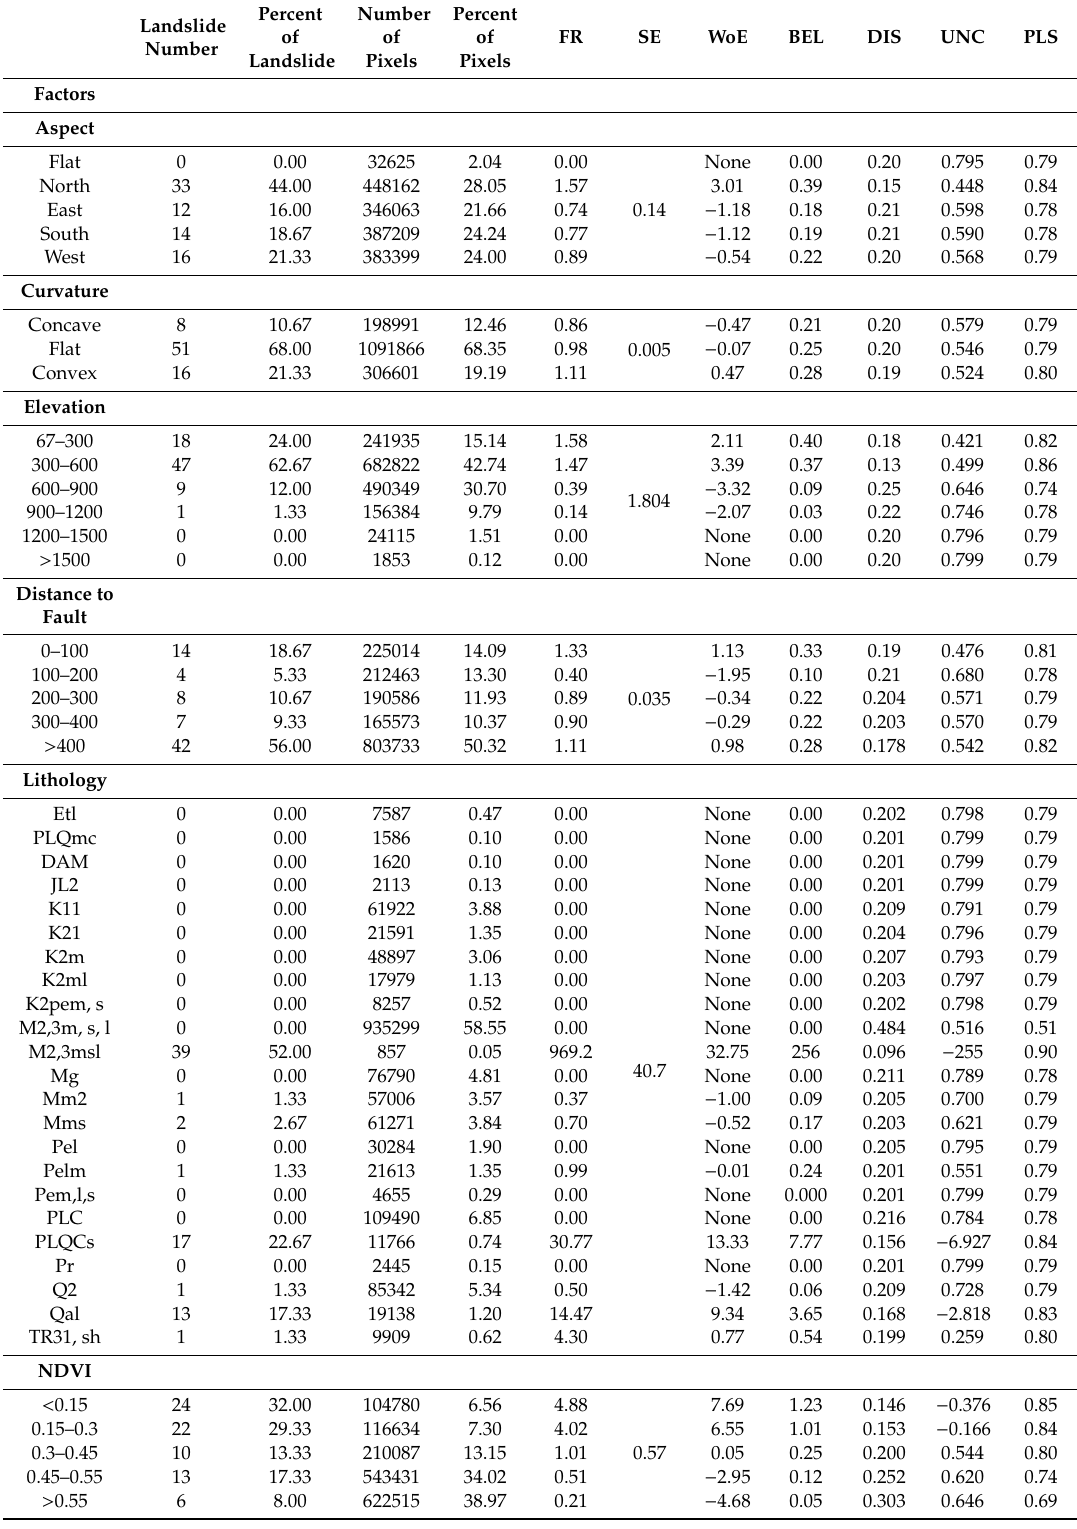
The correlation between occurring landslides and each conditioning factor using bivariate